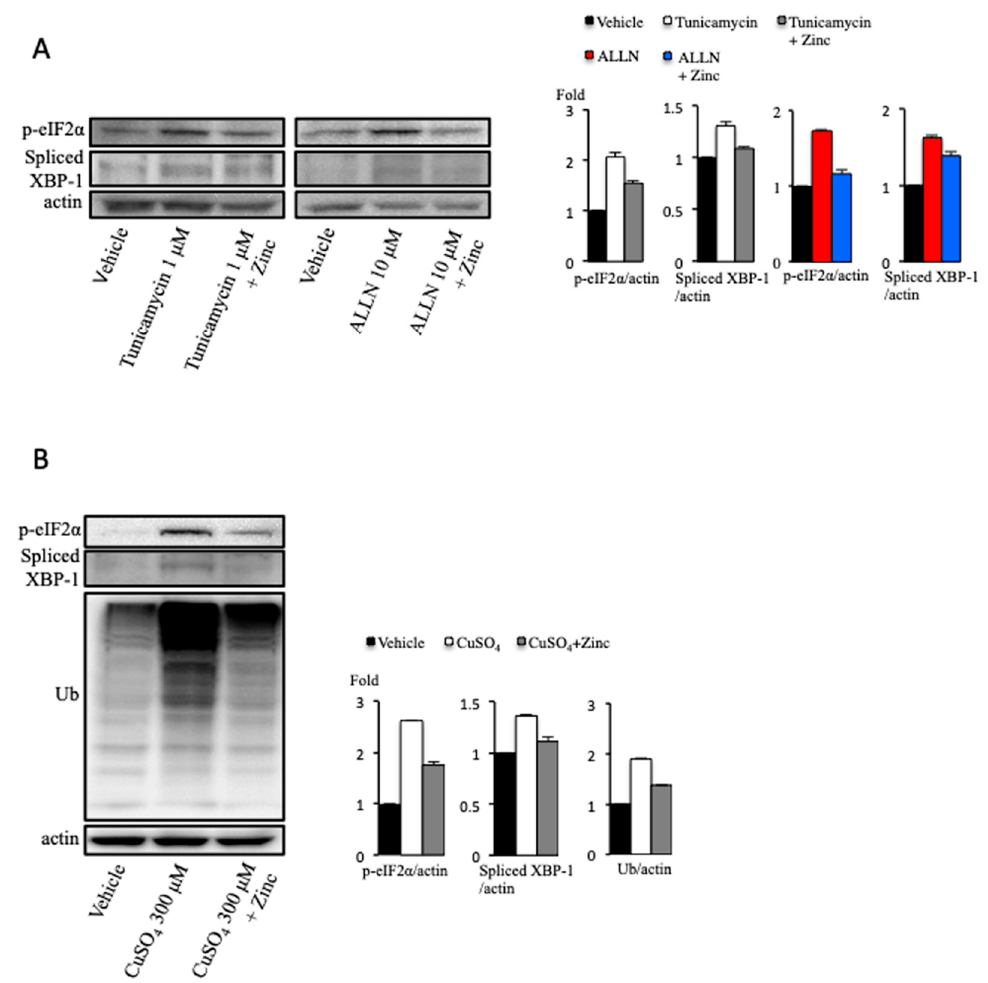
Figure 1. Effect of copper on endoplasmic reticulum (ER) stress. ( A ) Huh7 cells were treated with tunicamycin 1 µ M or acetyl-leucyl-leucyl-norleucinal (ALLN) 10 µ M for 12 h, and zinc acetate (200 µ M) was added 2 h before these treatments. Densitometry analysis of indicated proteins is shown on the right. ( B ) OUMS-29 cells were treated with copper at the concentration of 300 µ M for 12 h, and zinc acetate (200 µ M) was added 2 h before copper sulfate treatment. Densitometry analysis of indicated proteins is shown on the right.